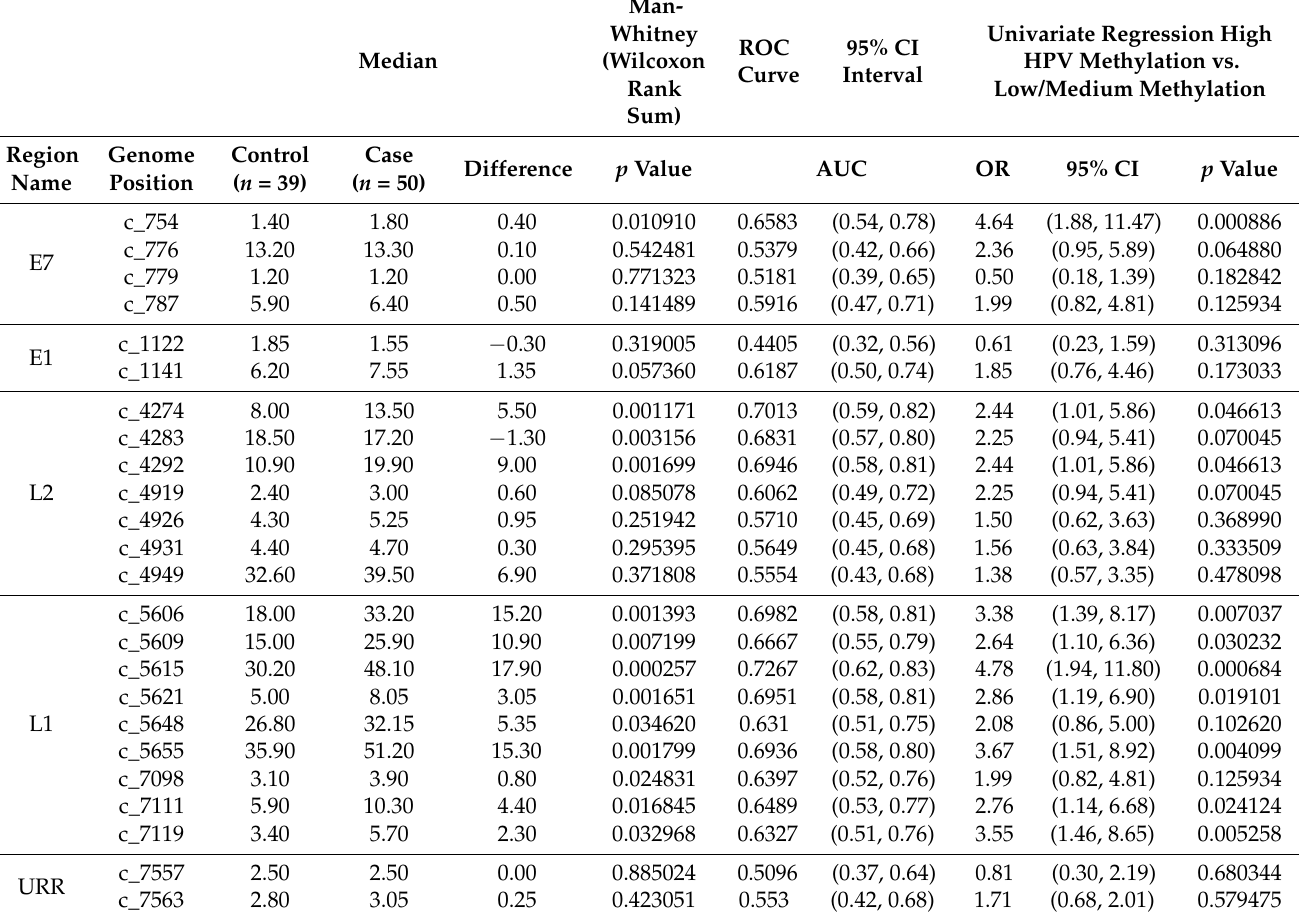
Table 1. Median methylation values of cases and controls by pyrosequencing. Median